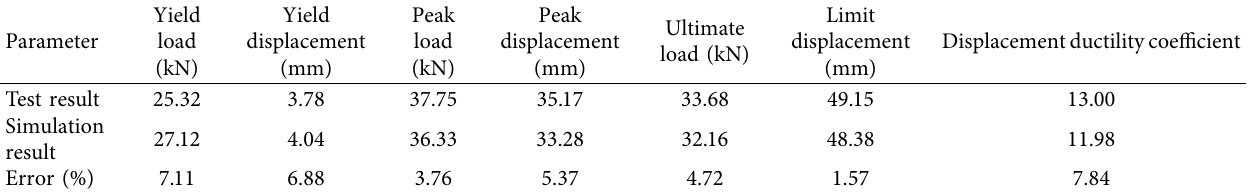
Table 7: The result comparison between the simulation and experiment.